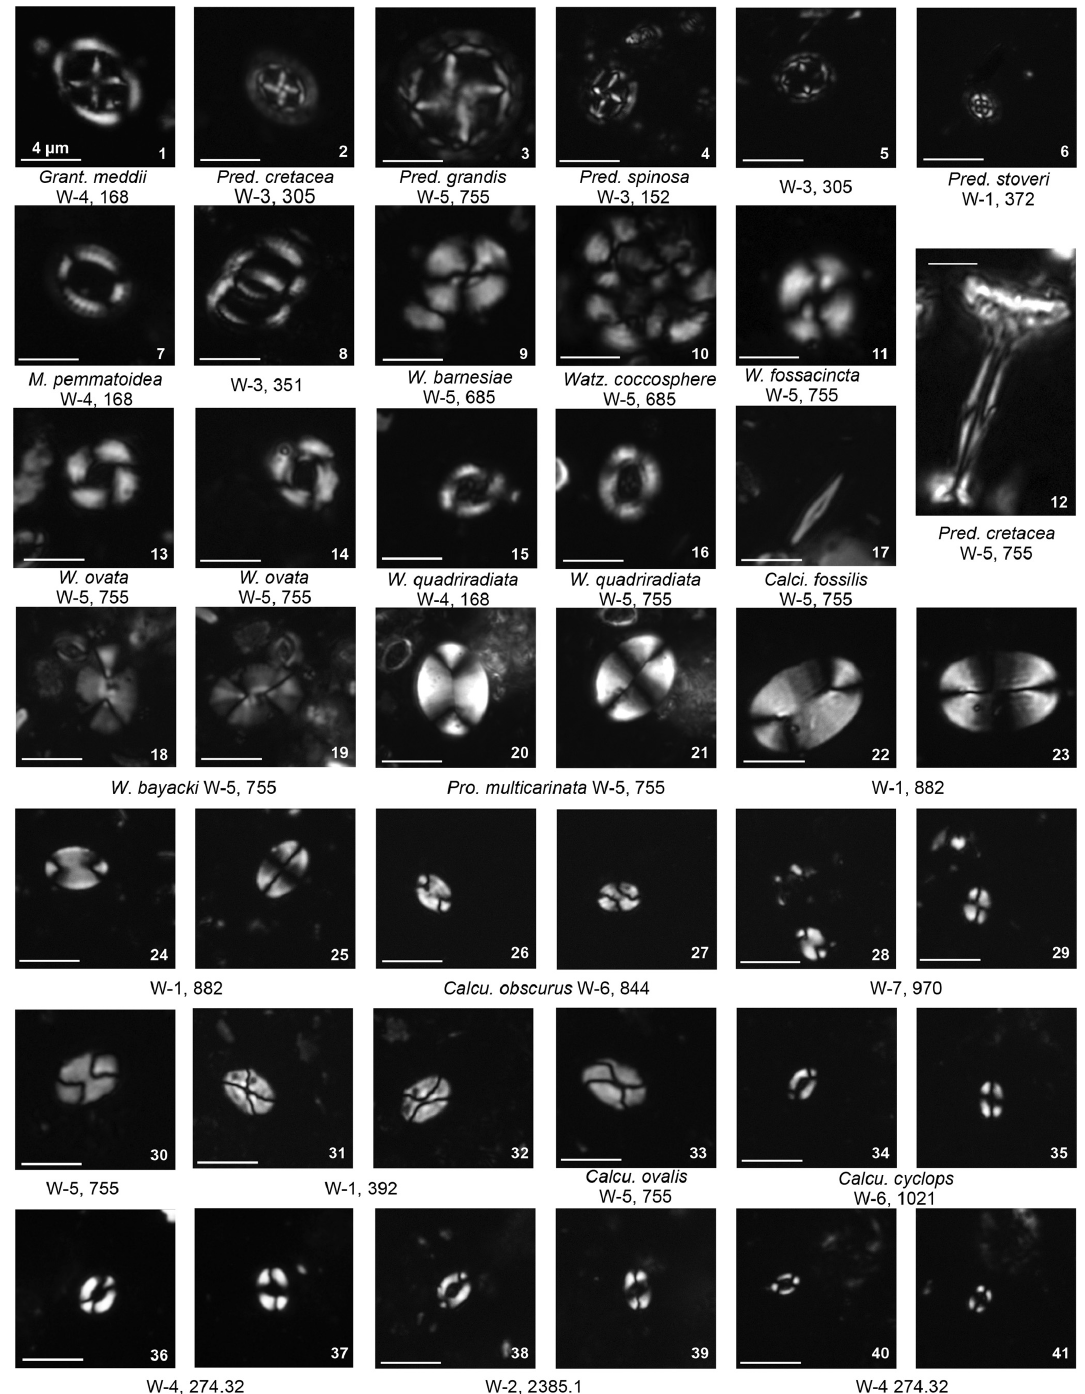
riales Watznaueriaceae : Watznaueria ; Syracosphaerales Calciosoleniaceae : Calciosolenia ; heterococcoliths inc sedis placoliths inc sedis: Prolatipatella ; holococcoliths common genera: Calculites